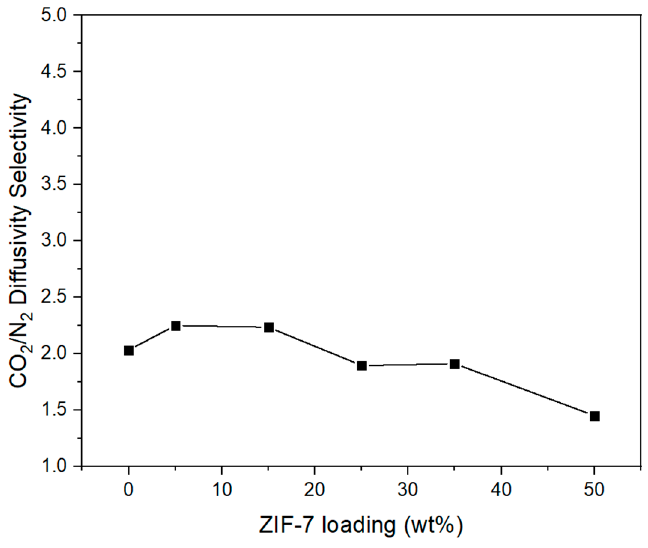
Figure 17. CO 2 /N 2 diffusivity selectivity of Pebax ‐ 2533/ZIF ‐ 7 composite membranes. Table 6. Gas diffusivity properties of Pebax ‐ 2533/ZIF ‐ 7 composite membranes.